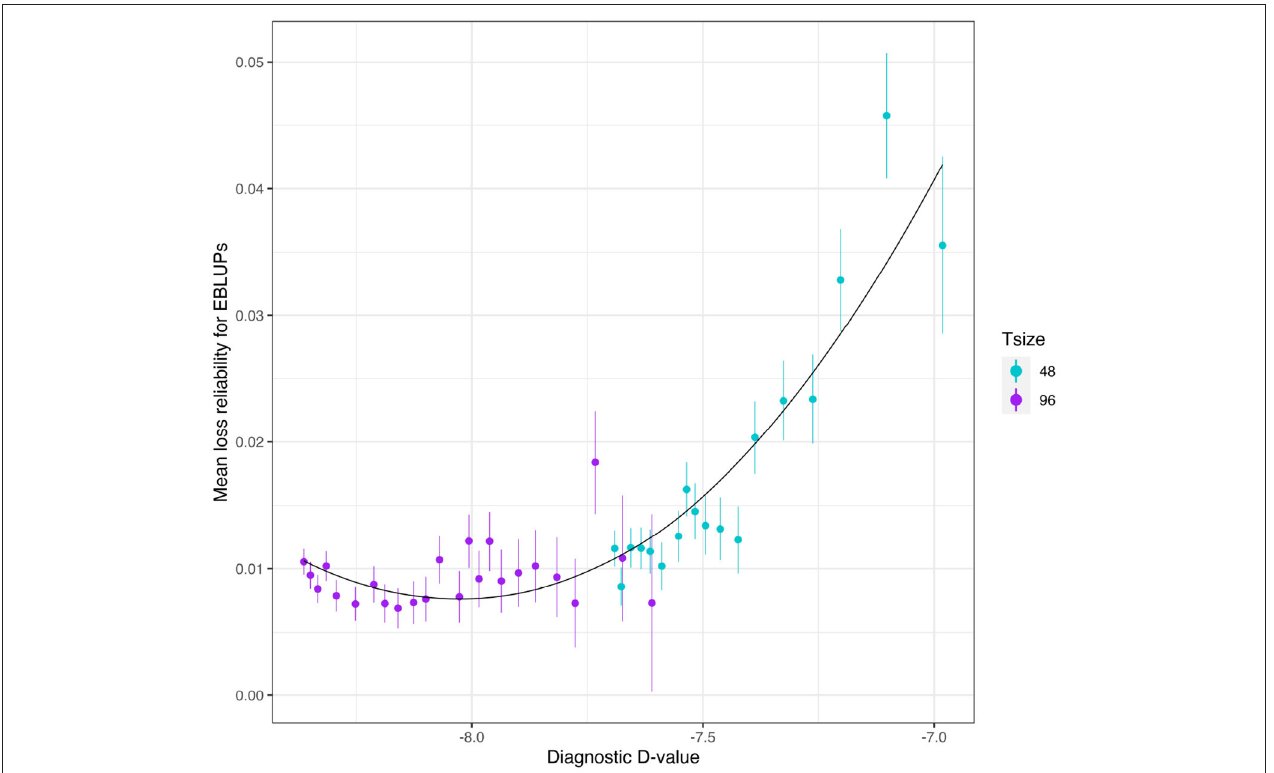
FIGURE 11 | Additive VE effects simulation study: mean loss in reliability of the EBLUPs of VE effects for Env1 for those varieties that were present in both environments. The colours correspond to different trial sizes (trials with 48 and 96 varieties) and the points for each colour correspond to a sequence of connectivity levels. Also shown are standard errors for each mean (vertical lines) and a loess smoother through all the